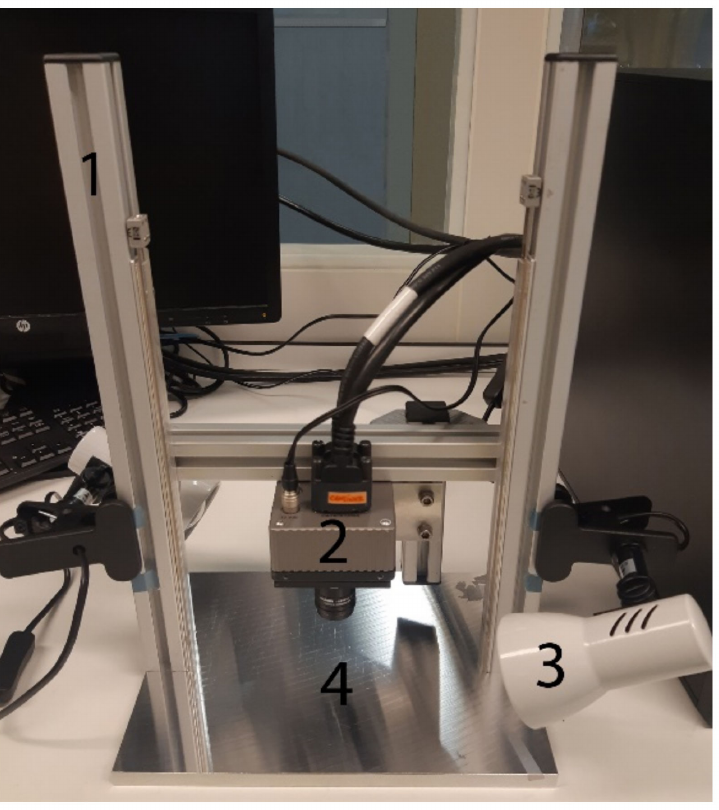
Figure 1. Hyperspectral data acquisition system, showing: 1. Vertical rigid stage; 2. Hyperspectral camera; 3. Halogen light source; 4.